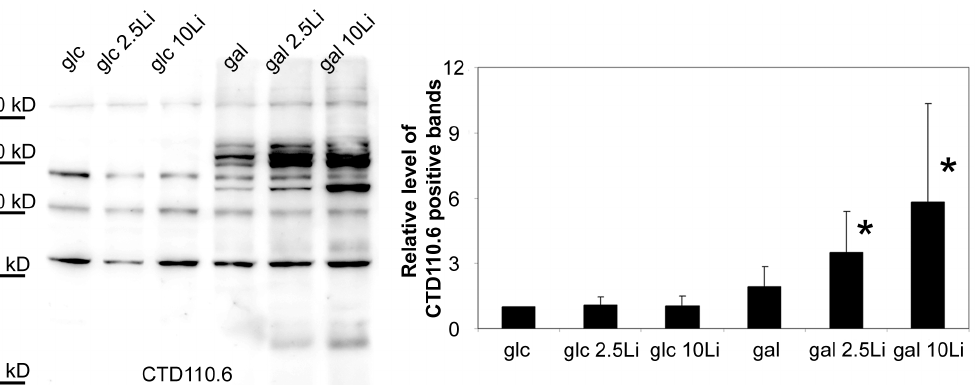
Figure 6. Lithium treated, galactose-fed cells show dose-dependent, apparent increase of O-GlcNAc proteins. Immunoblotting with CTD110.6 antibody in protein extracts from Jurkat cells. Cells were incubated in 5 mM glucose or 5 mM galactose containing media for 48 hours, with 0, 2.5 or 10 mM lithium. Left: Representative western-blot analysis showing cellular extracts of Jurkat cells separated using SDS-PAGE and labelled with CTD110.6 antibody. Right: Densitometric analysis of CTD110.6 positive bands. Relative levels are expressed as fold increase compared to the control, 5 mM glucose-grown cells. Data are means 6 SD from 4 independent experiments after normalized for total protein staining. *P , 0.05 vs. glc.